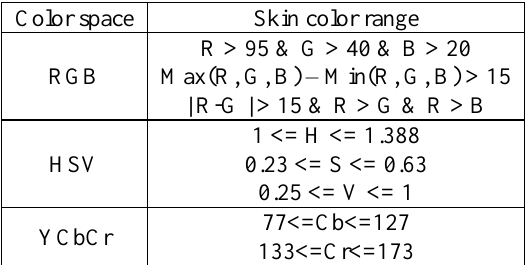
Table 1. Skin color ranges Color space